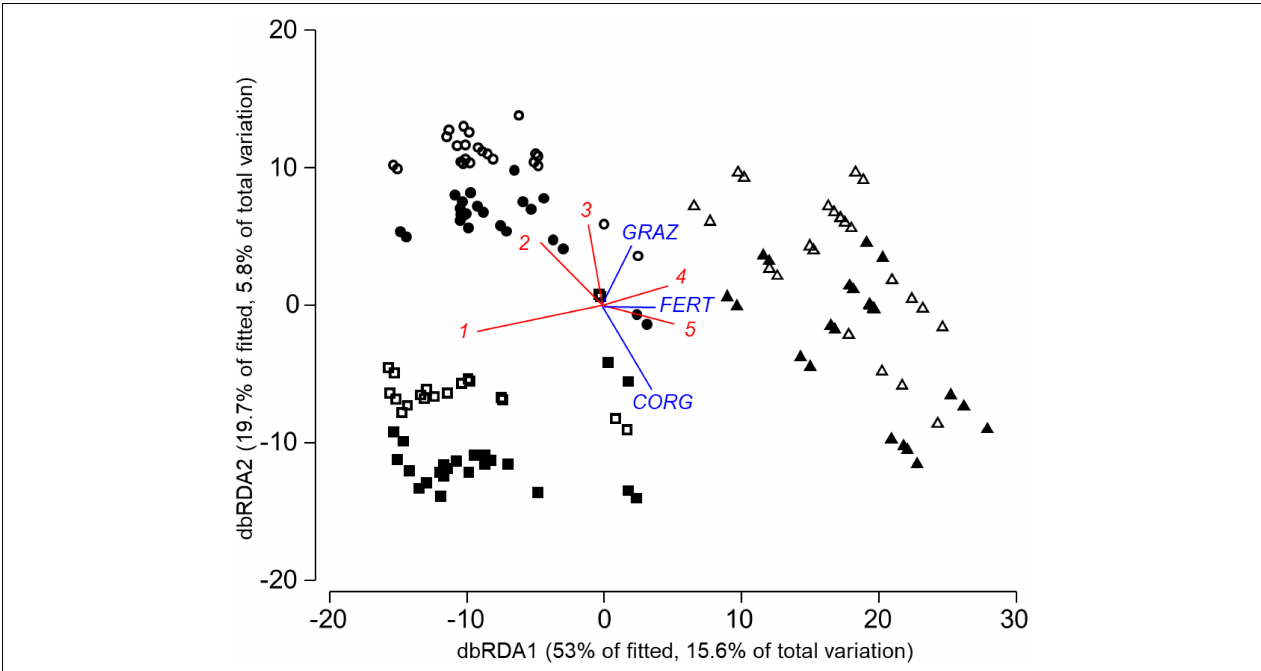
FIGURE 2 | Distance-based RDA plot of study plots based on Nematode community data and the model in Table 3B from AEG ( (cid:110) ), HEG ( (cid:108) ) and SEG ( (cid:115) ) with samples from spring (solid) and autumn (open) 2008. Individual predictor variables from selected indicator groups of the model in Table 3B are superimposed (CORG, soil organic carbon content; GRAZ, average livestock density 2006–2008; FERT, average fertilizer amount 2006–2008). Nematoda genera with correlation coefficients > 0.3 between axis scores of sites and abundances are superimposed with (1) Prodorylaimus , (2) Helicotylenchus , (3) Amplimerlinius , (4) Tylenchorhynchidae, and (5) Eucephalobus .